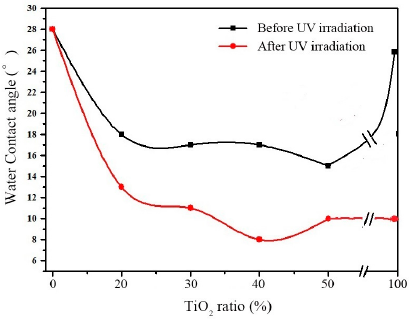
Figure 3. Relationship between the water contact angle and the content of TiO 2 .